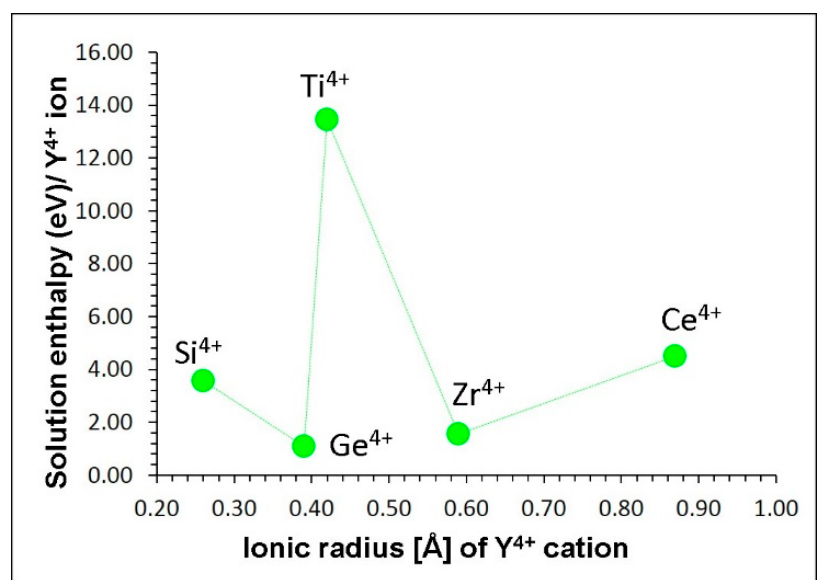
Figure 6. Solution enthalpies of YO 2 (Y = Si, Ti, Ge, Zr and Ce) with respect to the Y 4+ ionic radius in